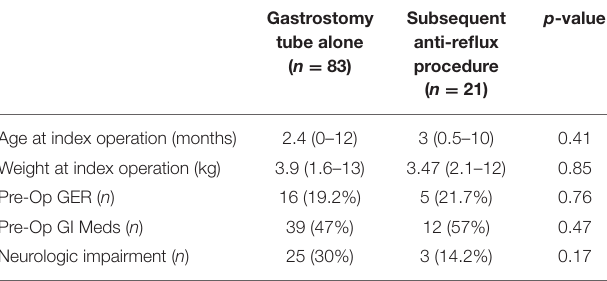
TABLE 2 | Comparison of GT alone vs. subsequent anti-reflux